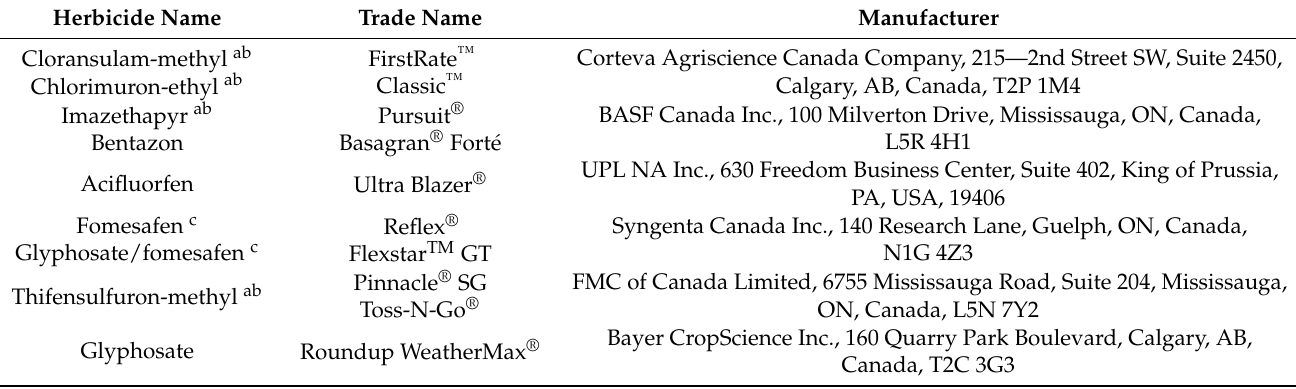
Table 4. Herbicide active ingredients, trade names, and manufacturers for POST herbicide